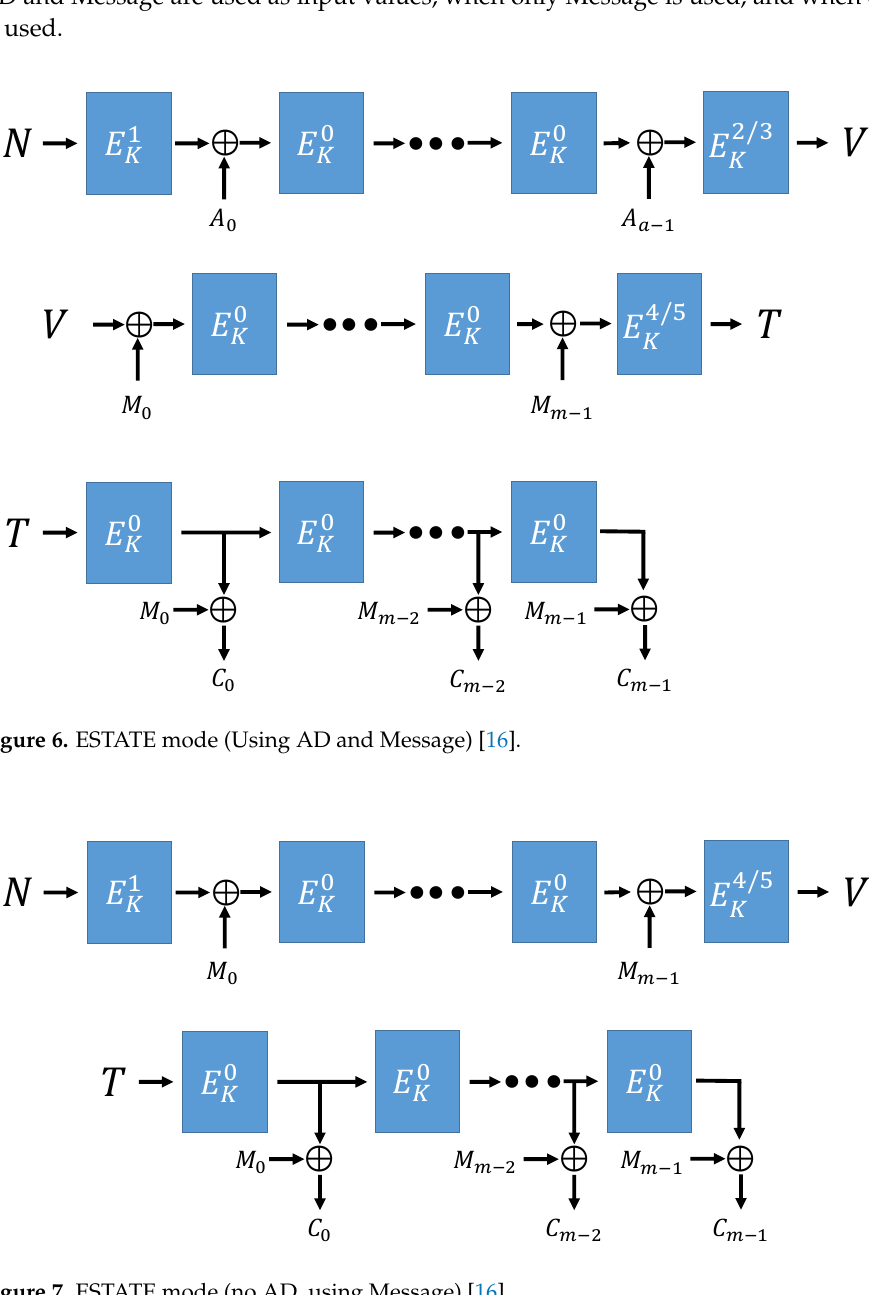
Figure 7. ESTATE mode (no AD, using Message) [16].